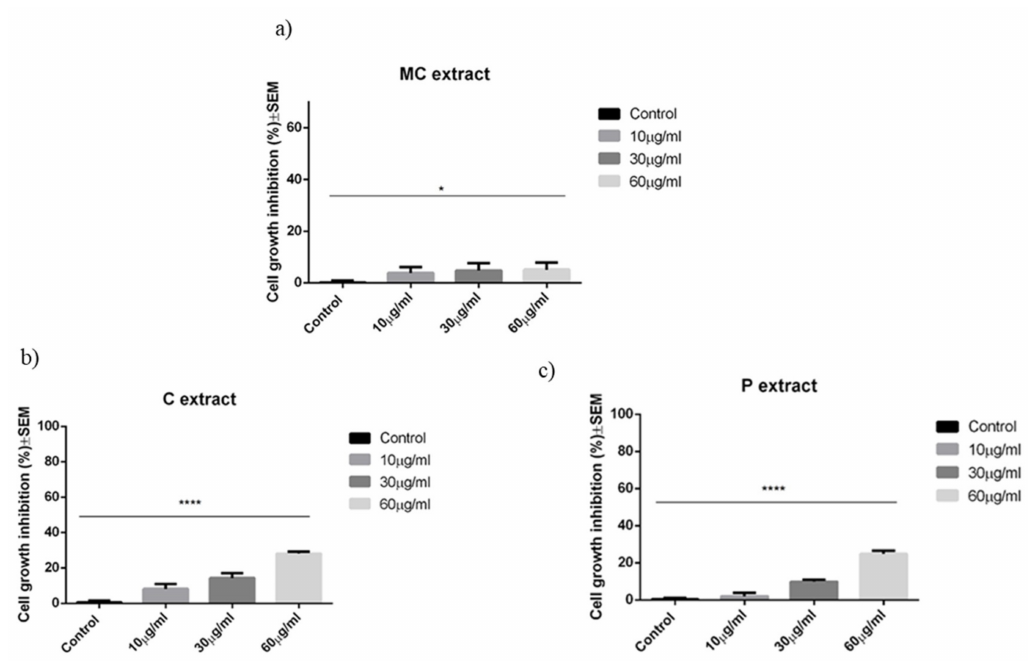
Figure 2. Cell growth inhibition (%) ± SEM against A375 human melanoma cells after 72 h of